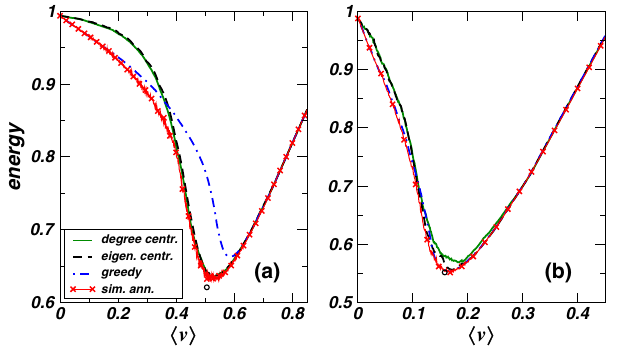
FIG. 14. Comparison between several immunization methods for the SIR model on two synthetic networks of N ¼ 1000 nodes: (a) Erdös-Rényi random graph of average degree z ¼ 10 and parameters q ¼ 0 . 1 , p ¼ 0 . 5 , and μ ¼ ϵ ¼ 1 . 0 ; (b) heterogeneous random graph with power-law degree distribution P ð k Þ ∝ k − γ with exponent γ ¼ 2 . 2 and parameters q ¼ 0 . 1 , p ¼ 0 . 9 , and ϵ ¼ 1 , μ ¼ 2 . The data represent the average energy as a function of the average fraction of immunized nodes h v i for degree centrality (green line), eigenvector centrality (black dashed line), the greedy algorithm (blue dot-dashed line), and simulated annealing (red crosses). The black circles (with error bars) are the results obtained using the MS algorithm.